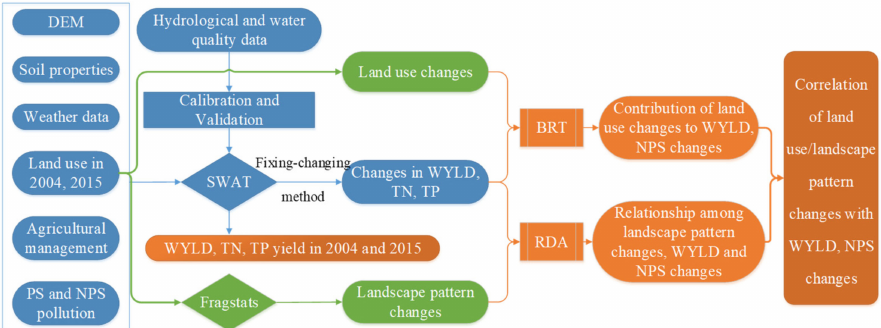
Figure 3. Schematic framework of the study. Digital elevation model (DEM), Point source (PS), Nonpoint source (NPS), Soil and Water Assessment Tool (SWAT), Water yield (WYLD), Total nitrogen (TN), Total phosphorus (TP), Bboosted regression tree (BRT), Redundancy analysis